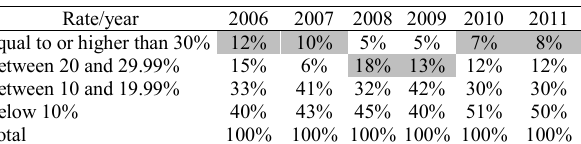
Table 3. Percentage of zoology journals in Sample 1 per self- cited rate intervals.